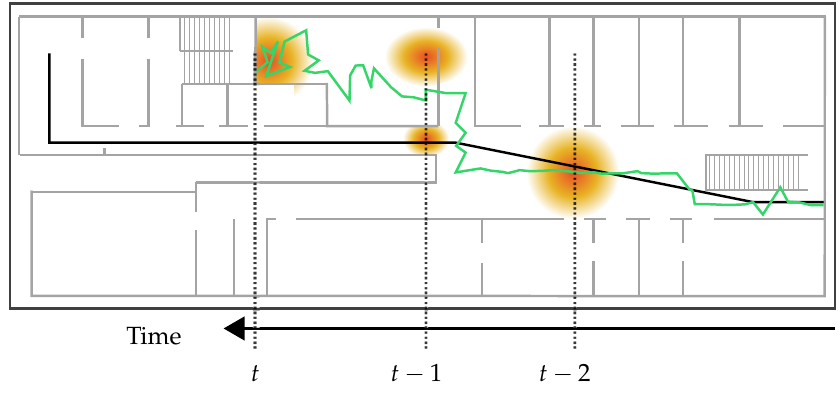
Figure 3. An example of the occurrence of sample impoverishment enhanced by a restrictive transition model that prevents sampling through walls. At time t − 1 the approximated position (green line) drifts apart from the ground truth (black line) due to uncertain measurements. The posterior distribution is then captured within the room and not able to recover by itself